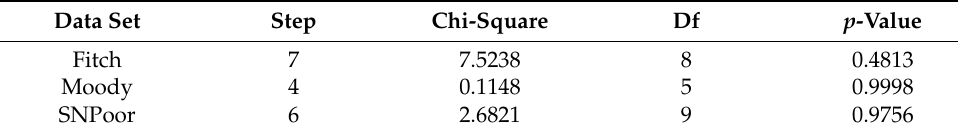
Table 5. Hoang et al. Test for